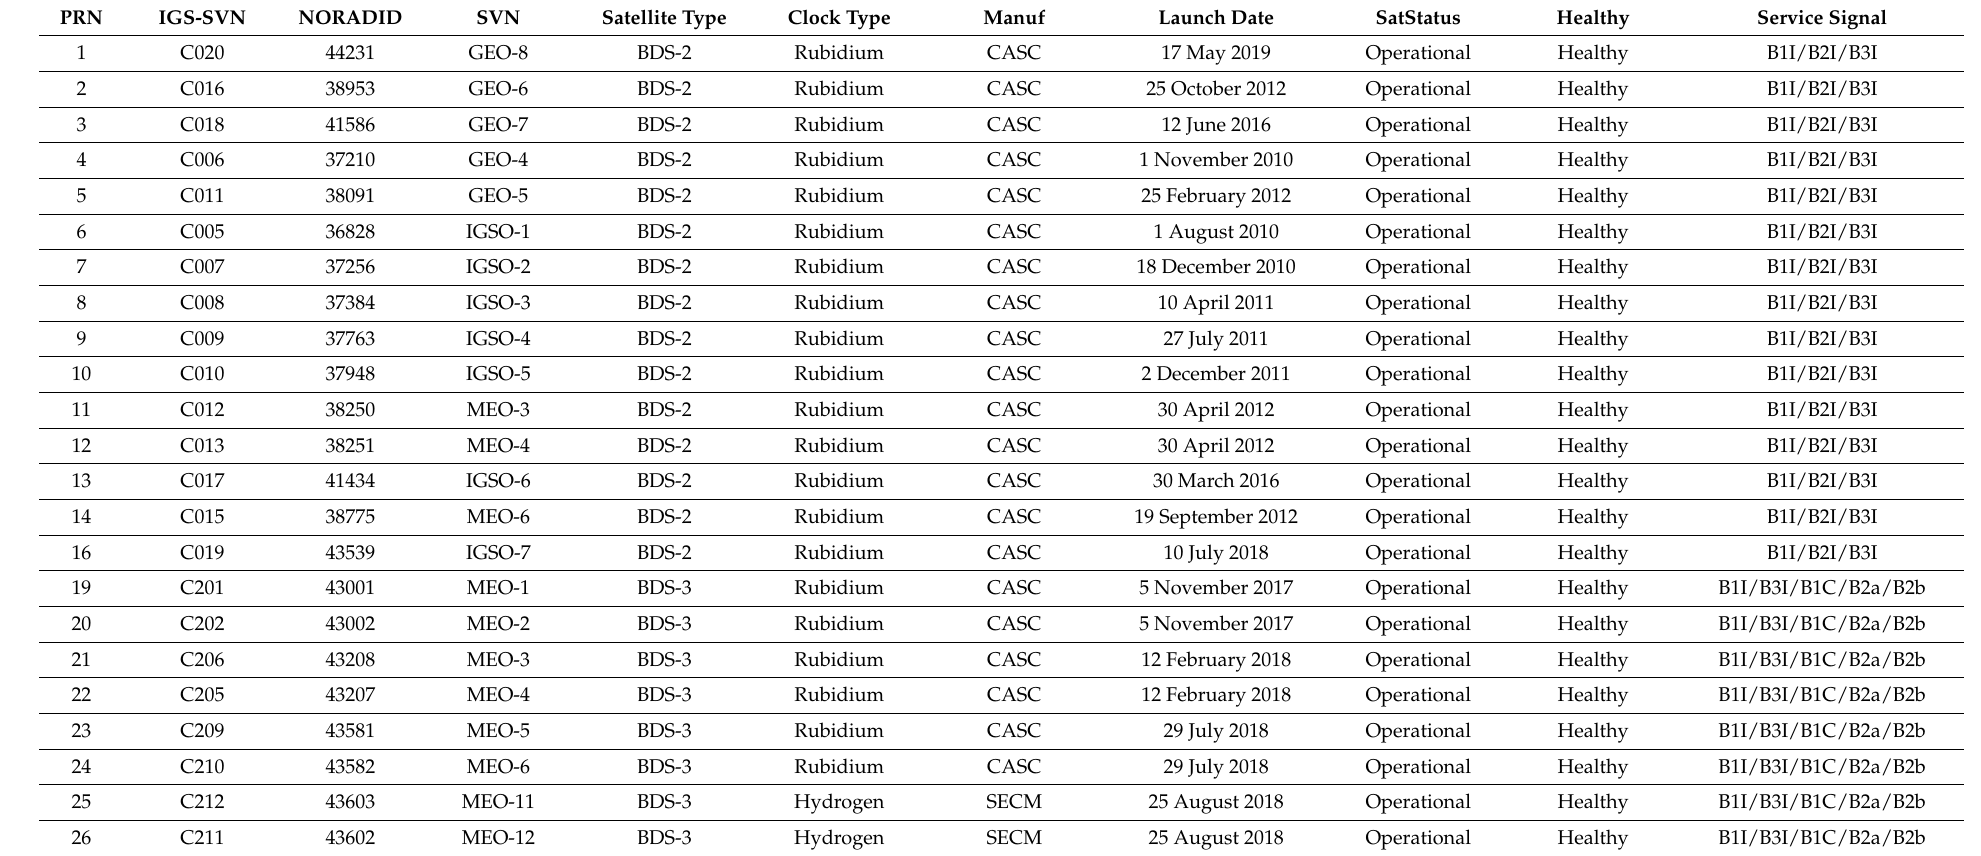
Table A1. BeiDou constellation status (http://www.csno-tarc.cn/en/system/constellation, access 1 June